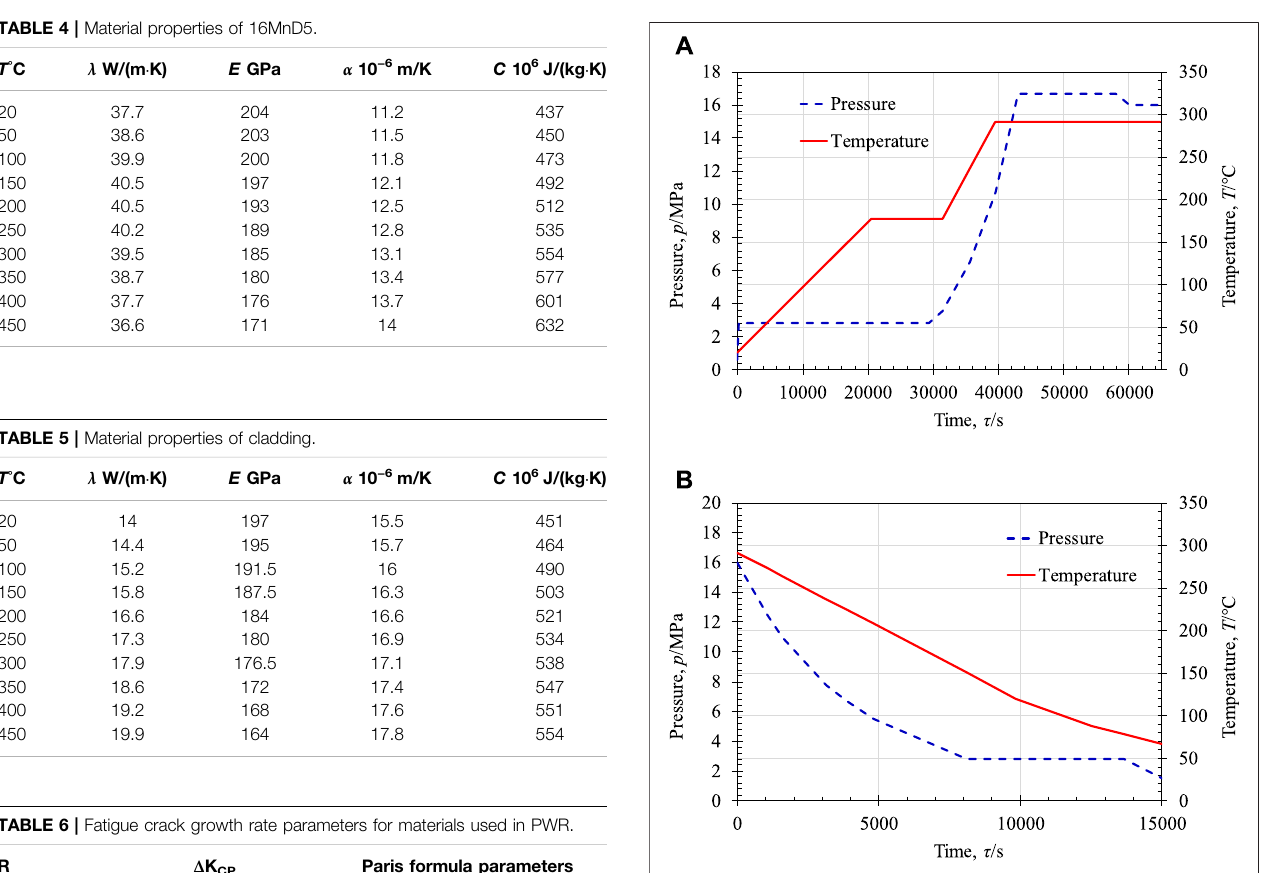
TABLE 6 | Fatigue crack growth rate parameters for materials used in PWR. R Δ K CP Paris formula parameters R ≤ 0.3 FIGURE 10 | Typical transients with the change of temperature and